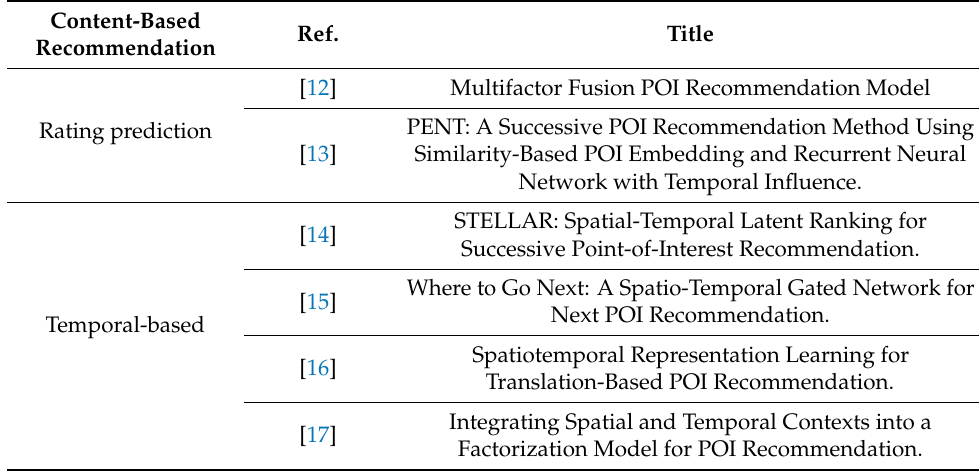
Table 1. Summary of previous studies on content-based POI